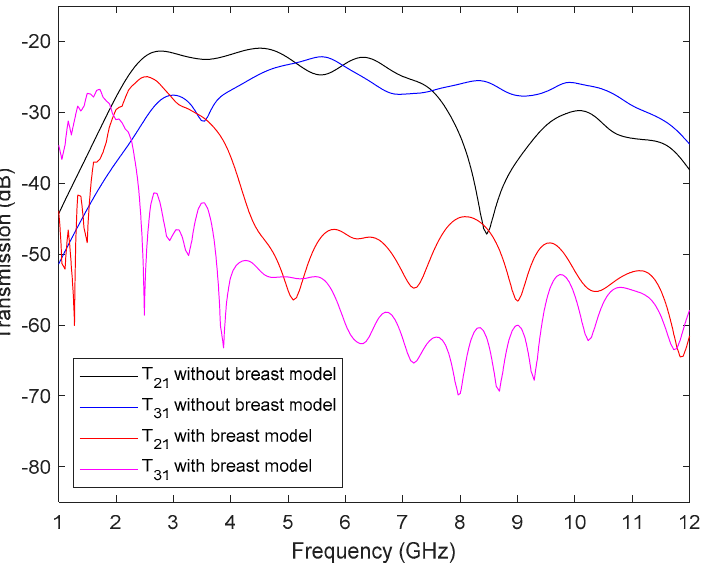
Figure 19. Transmission parameter between adjacent and opposite antennas with and without the breast model.